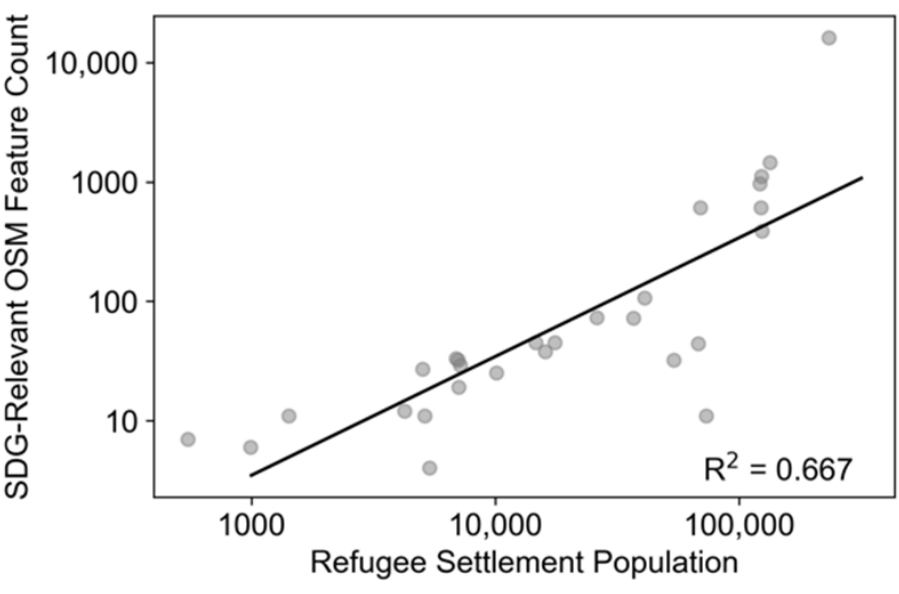
Figure 17. Positive relationship between refugee settlement populations and settlement-level counts of SDG-relevant OSM features. Note the logarithmic scale of both axes.